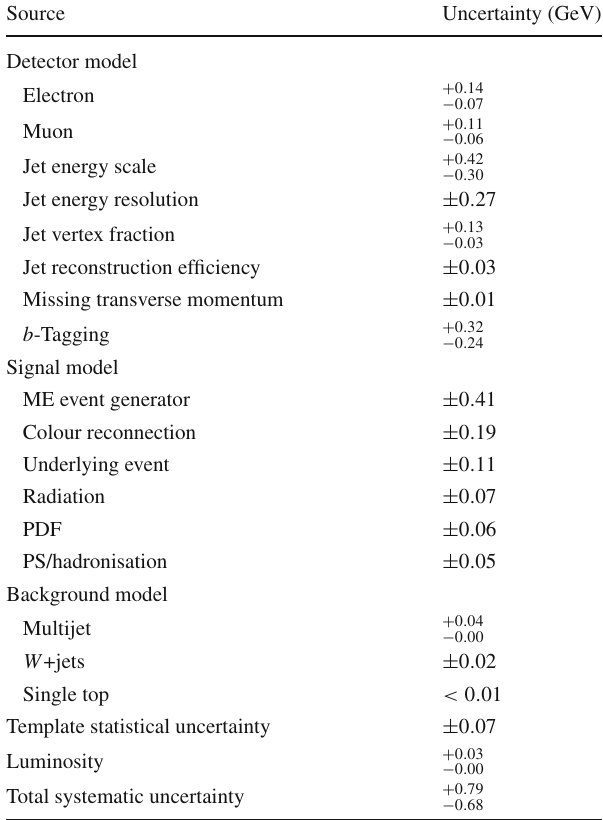
Table 2 Summary of systematic uncertainties in the top-quark decay width